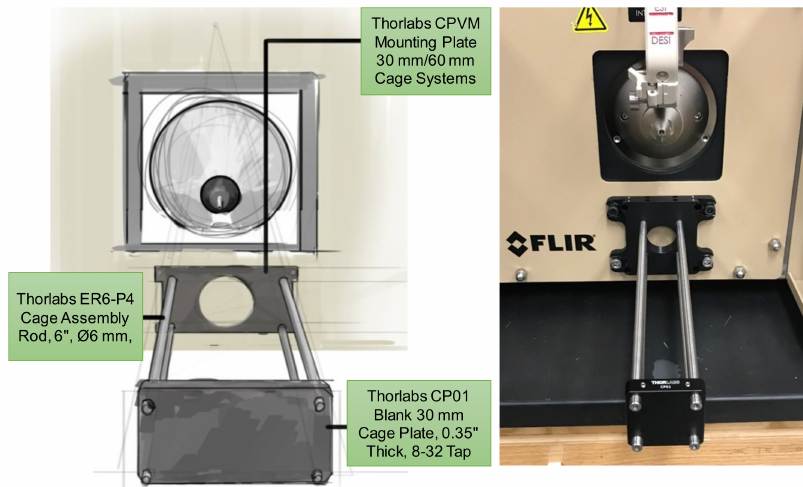
Figure 1. Centralized, rail-based mounting system to allow “plug-and-play” style operation of modular paper spray ionization (PSI), paper cone spray ionization (PCSI), atmospheric pressure chemical ionization (APCI), and swab touch spray ionization (STSI) sources, based upon stock optical consumables from Thorlabs Inc. (Newton, NJ, USA). The vertical mounting plate is attached directly with minor modification to front plate of FLIR AI-MS. The cage assembly rods are attached to the mounting plate and secured by the blank cage